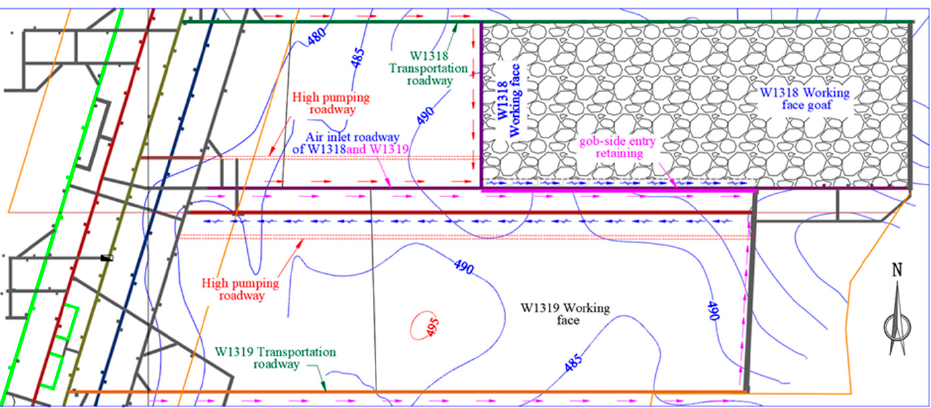
Figure 2. Layout of working faces and